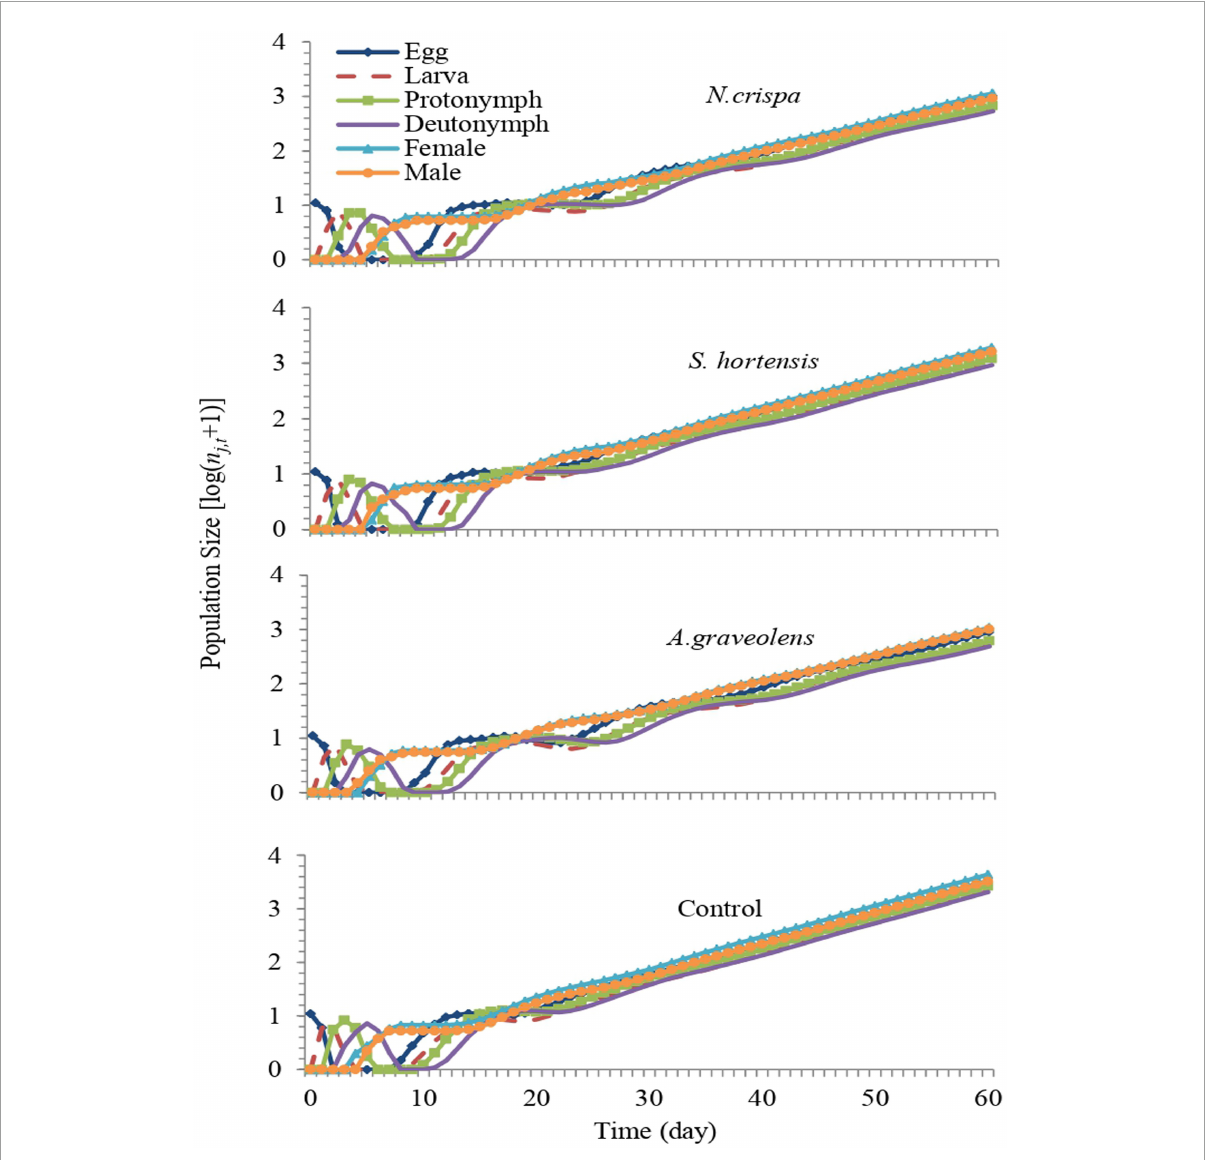
FIGURE7 Population growth of A. swirskii from control and treatments of N. crispa , S. hortensis , and A. graveolens